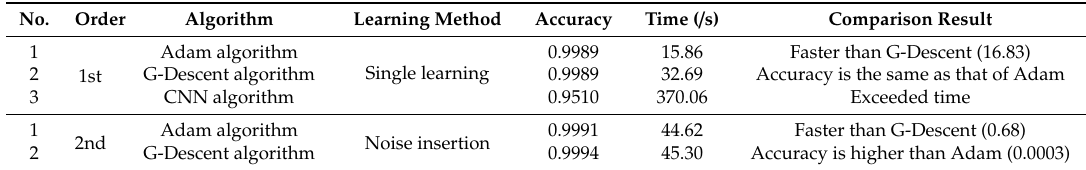
Table 4. Experiments with three algorithms of machine